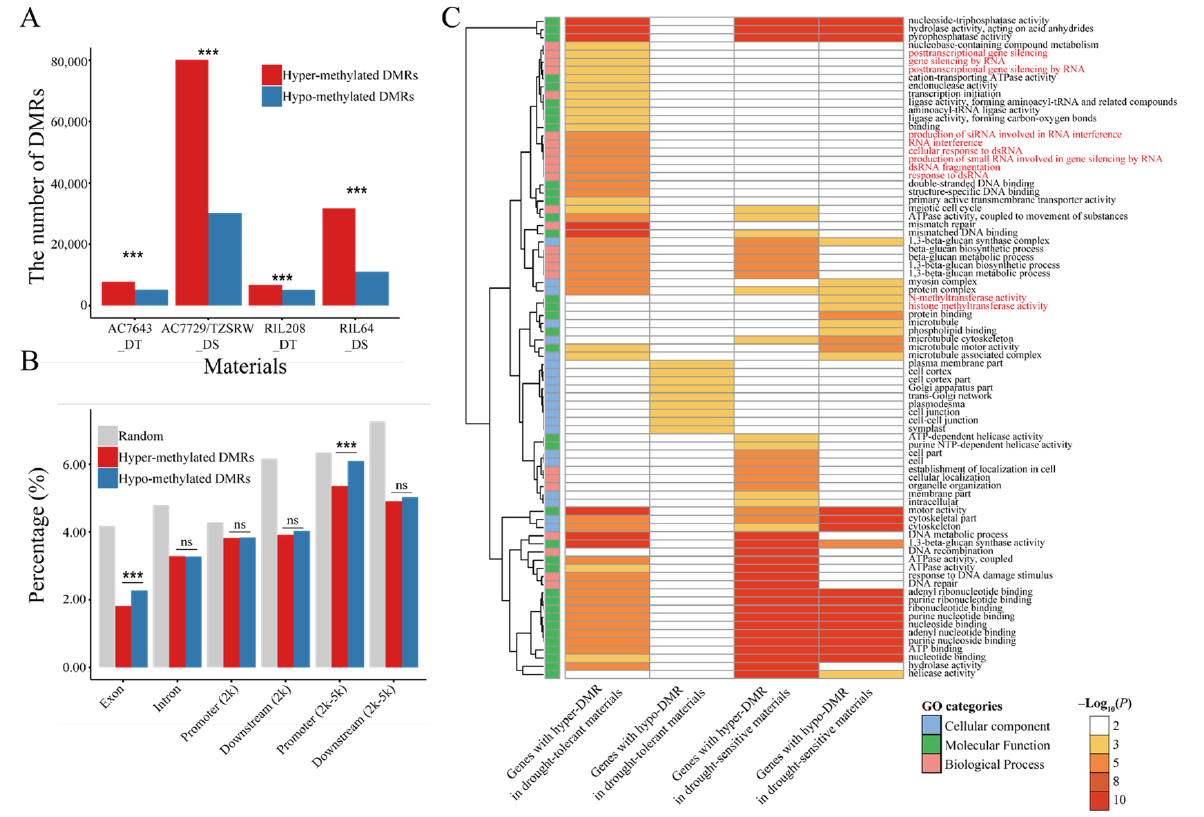
Figure 3. Summary of differentially methylated regions (DMRs). ( A ) The number of DMRs in four inbred lines. Hyper-DMRs mean regions where DNA methylation levels increased under WS, while hypo-methylated DMRs stand for regions of decreased DNA methylation levels under WS. ***: p < 0.001, χ 2 test. ( B ) The proportions of DMRs located in different genetic elements. ***: p < 0.001, ns: not significant, χ 2 test. ( C ) Gene Ontology (GO) enrichment terms of genes with DMRs in gene body. Genes involved in establishment and maintenance of DNA methylation were highlighted by red color.